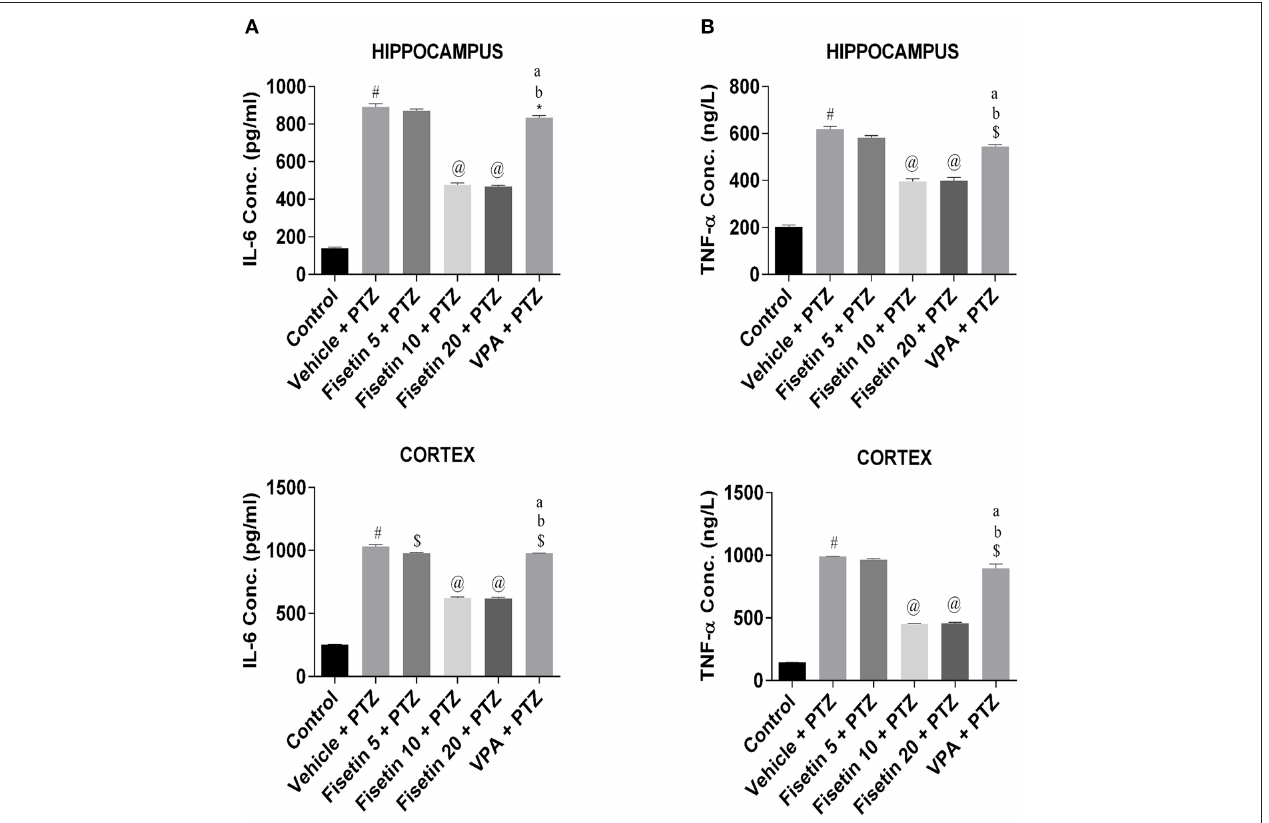
FIGURE 4 | Effect of Fisetin Administration on IL-6 and TNF-a Levels in the Hippocampus and Cortex of Experimental Mice. (A) IL-6 and (B) TNF- α in the hippocampus and cortex of kindled mice. The concentrations were measured in hippocampus and cortex of experimental animals using ELISA kits. Fisetin administration significantly lowered the levels of cytokines in a dose-dependent manner in the hippocampus and cortex tissues. Data were analyzed by one-way ANOVA followed by Tukey’s multiple comparison test ( n = 6) and expressed as mean ± SEM. # p < 0.001 as compared with control; * p < 0.05 as compared with vehicle + PTZ group; $ p < 0.01 as compared with vehicle + PTZ group; @ p < 0.001 as compared with vehicle + PTZ group; a p < 0.001 as compared with fisetin 10 + PTZ group and b p < 0.001 as compared with fisetin 20 + PTZ